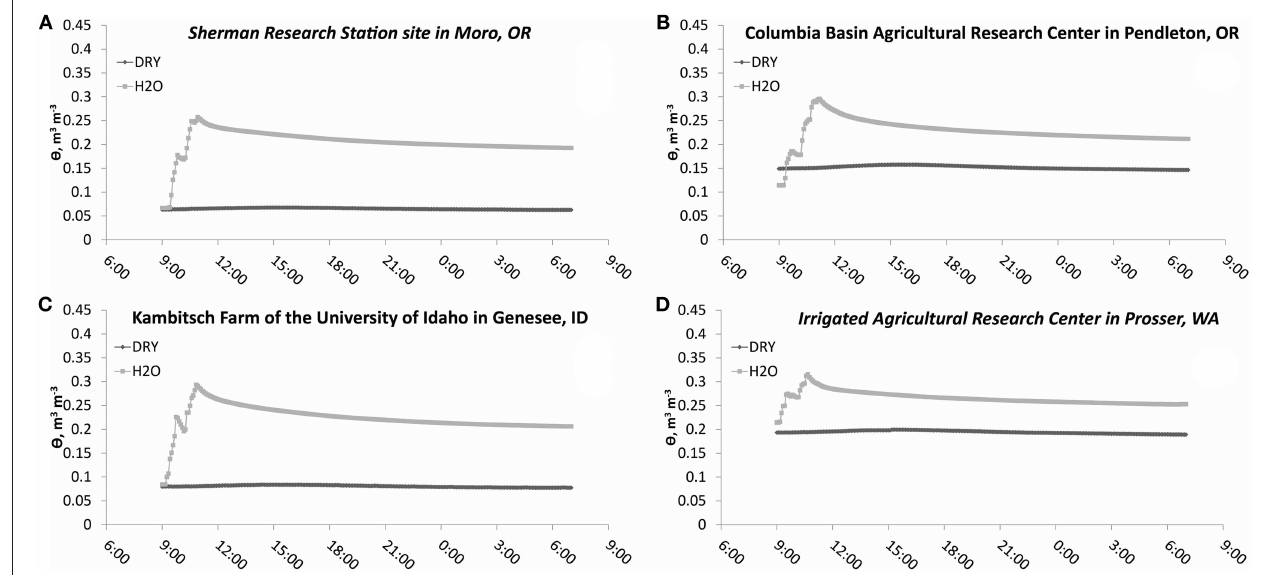
FIGURE 2 | Soil water (20cm depth) fluctuations in dry treatments and treatments with water additions during study over the course of 22h. DRY is the average of CT DRY and NT DRY; H2O is the average of CT H2O + N, NT H2O + N, CT H2O, and NT H2O treatments. Water filled pore space reached 60% at the following